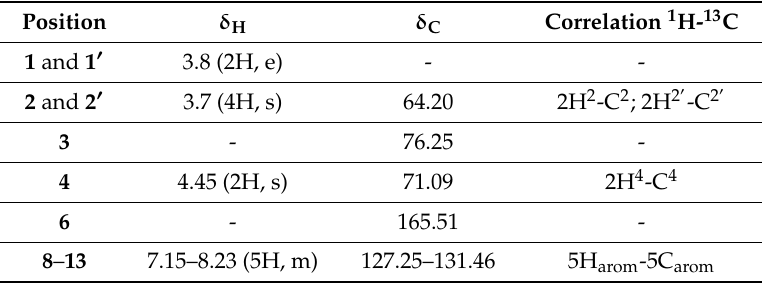
Table 1. 1 H (300 MHz) and 13 C (75 MHz) NMR spectral data for compound 2 in acetone- d 6 , including the obtained results by homonuclear 2D shift-correlated and heteronuclear 2D shift-correlated. Chemical shifts δ in ppm.